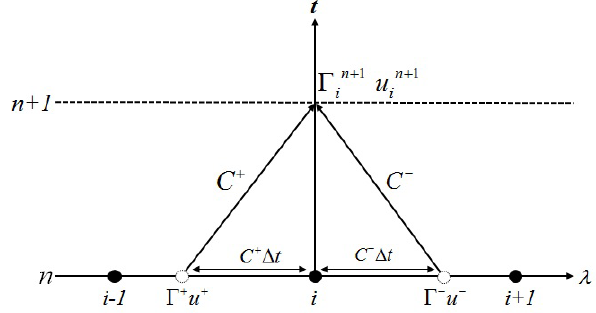
Figure 1. Space–time diagram showing the characteristic curves C ± where black points represent the grid points, white points represent the values (cid:48) ± and u ± at time n to be interpolated to find (cid:48) n + 1 and u n + 1